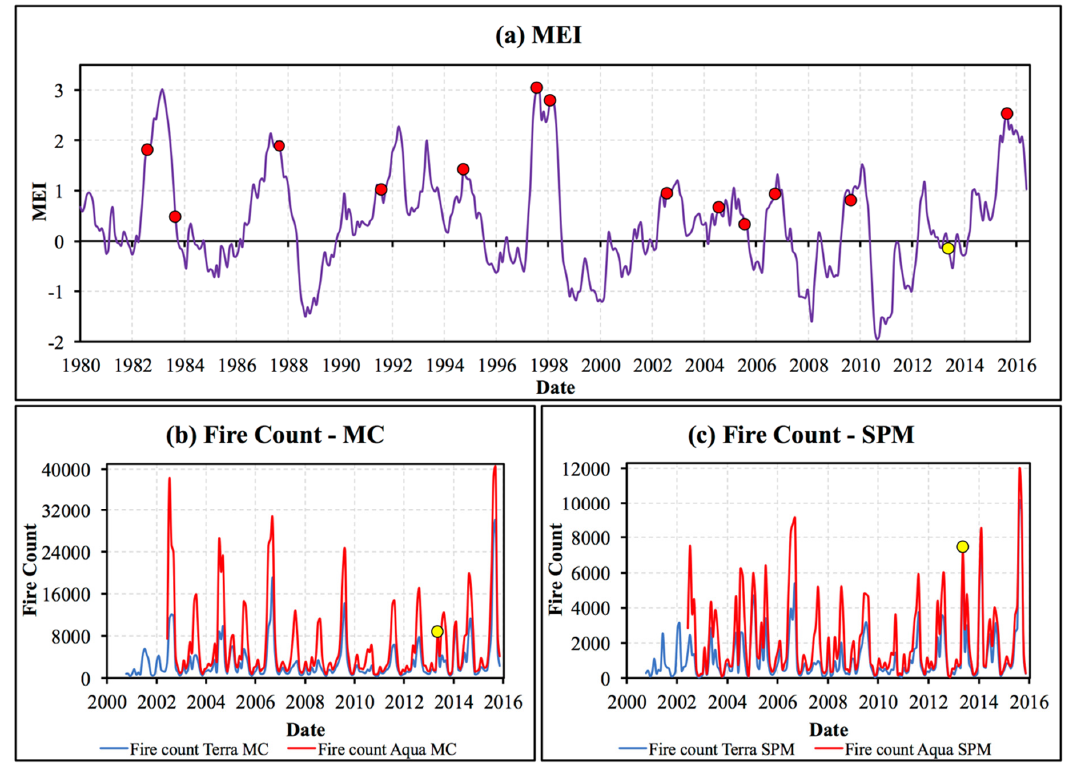
Figure 5. Time series data for the El Nino/Southern Oscillation (ENSO), fire over the Maritime Continent (MC) and MJO. ( a ) Multivariate ENSO Index (MEI) for 1980–2016. The red markers correspond to haze episodes that occurred when El ‐ Nino conditions prevailed, from left to right, August–September 1982,